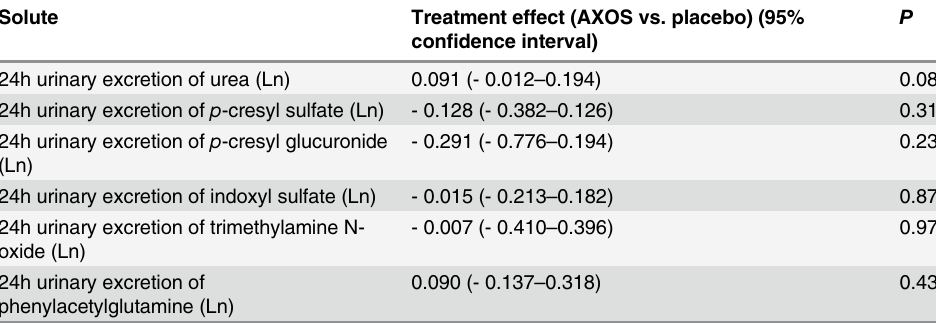
Table 3. Influence of arabinoxylan oligosaccharides (AXOS) on 24h urinary excretion of microbial metabolites. Solute